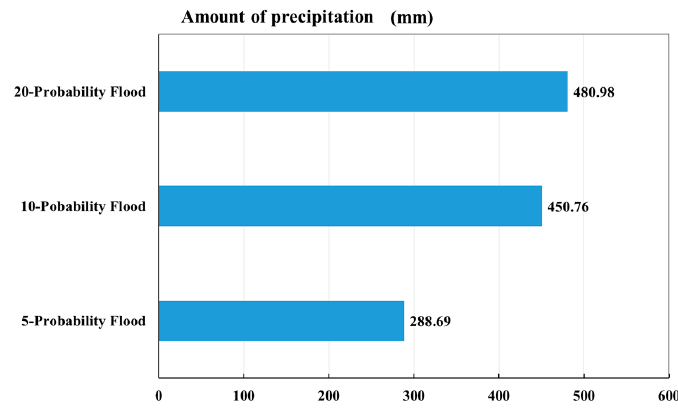
Figure 2. Precipitation with 5%, 10% and 20% flood probability from June to